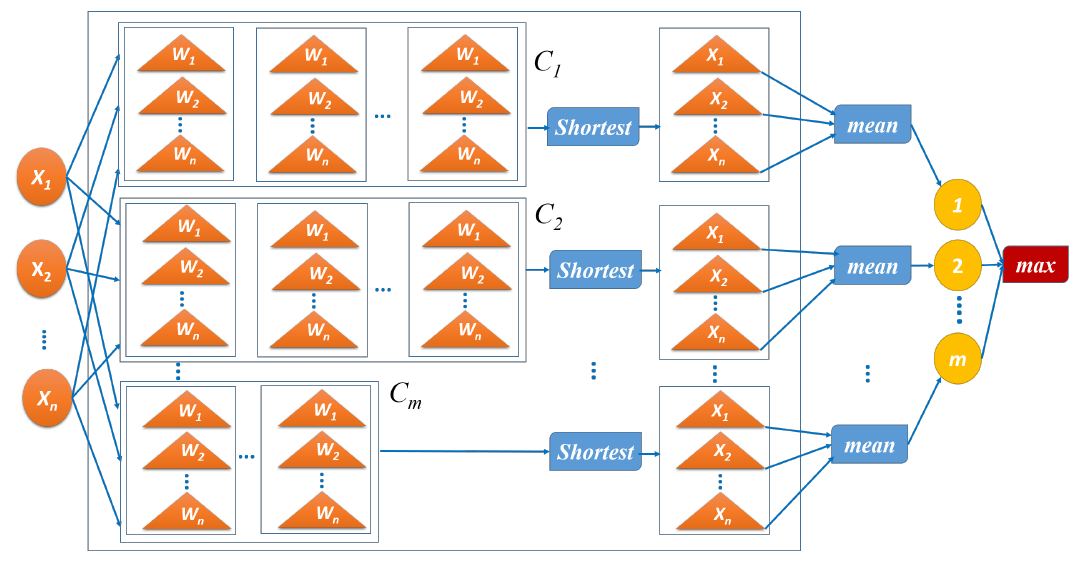
Figure 5. Multicodebook FNGLVQ